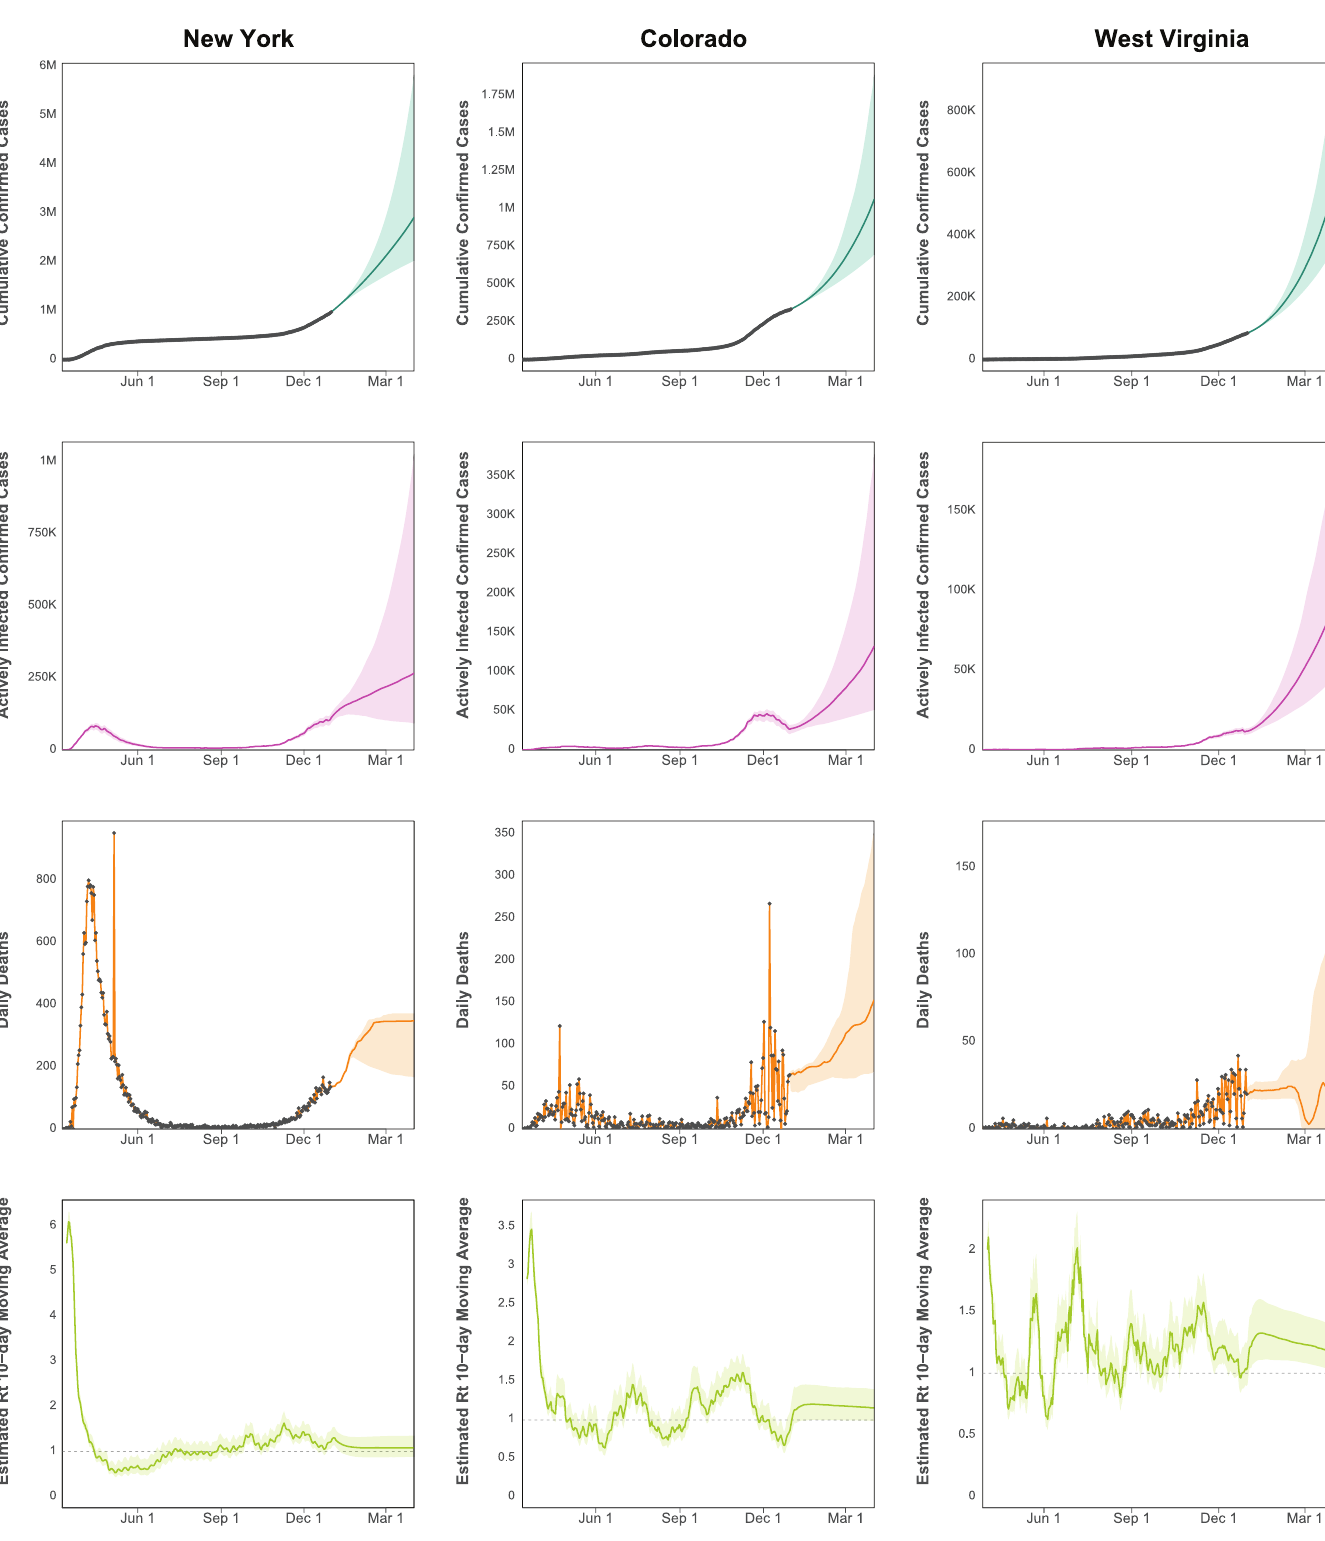
. Projected cumulative case count, active confirmed infections, and daily deaths through t